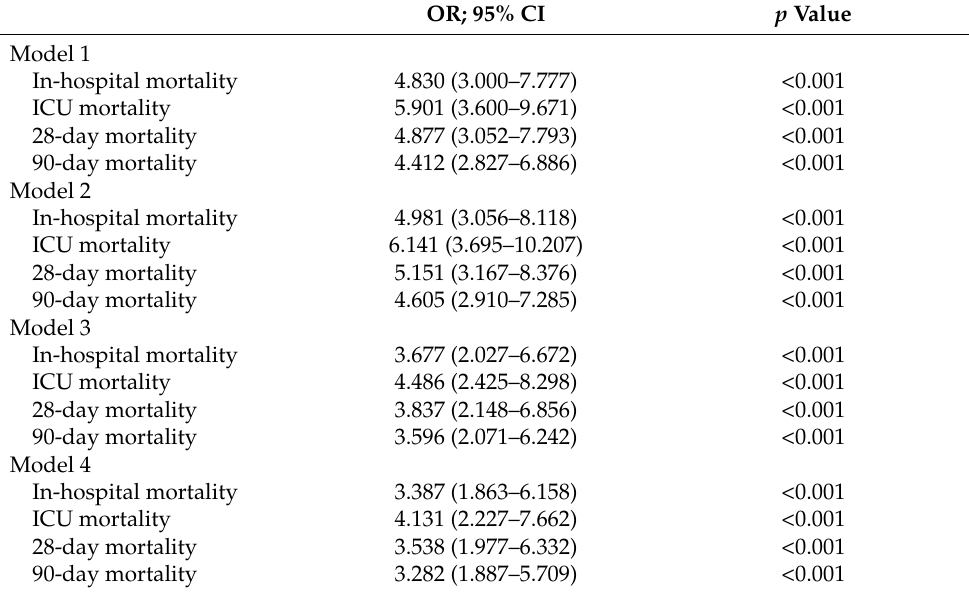
Table 2. The association between acute hepatic injury and outcomes in AMI patients.